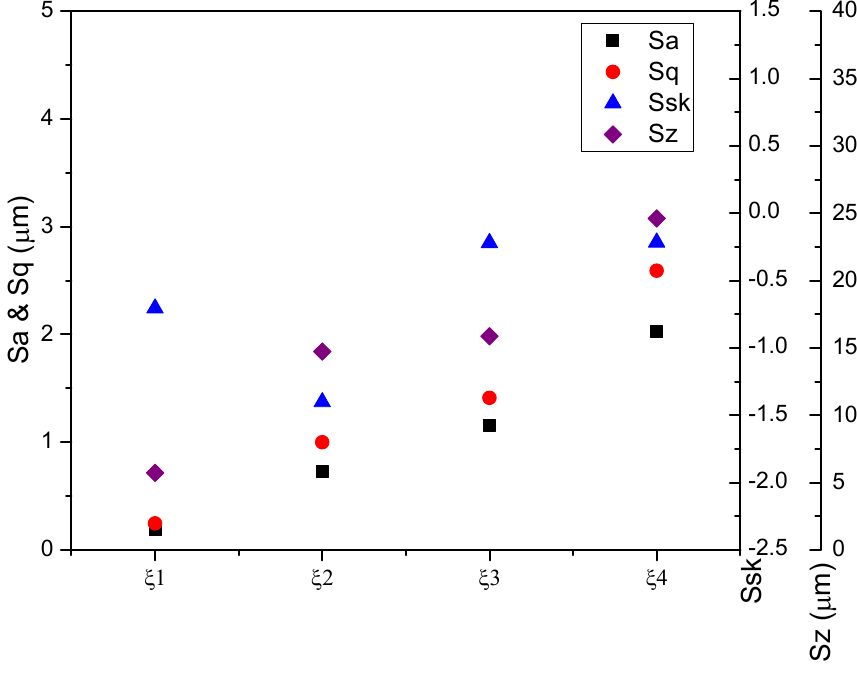
Figure 3. Results of the surface roughness parameters of test plates. Table 2. Definition and formula of roughness parameters.